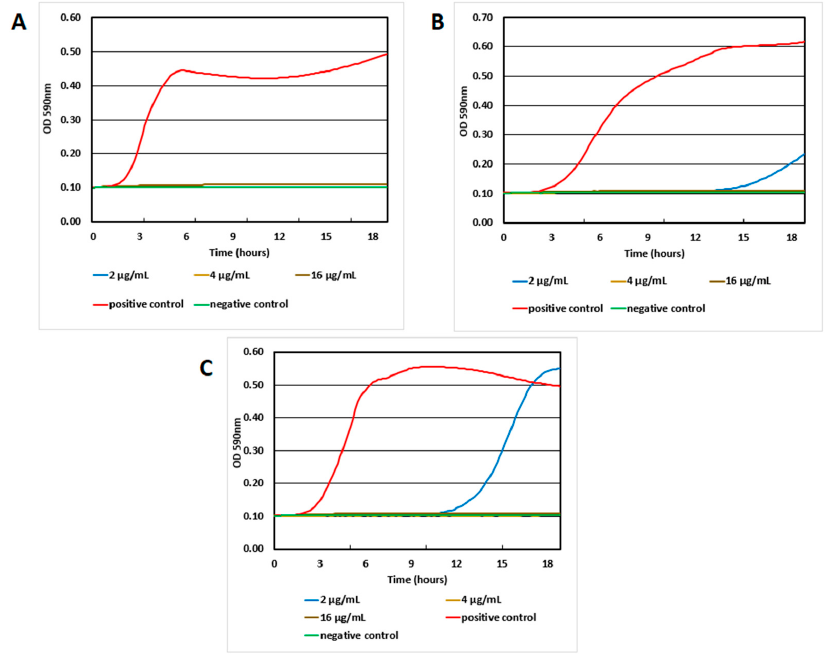
Figure 5. Bacterial growth inhibition exhibited by 7e against ( A ) S. aureus ATCC 25923, ( B ) S. aureus MRSA (CF-Marseille); ( C ) Bacillus cereus ATCC 11778 with different concentrations. Positive control was bacteria only and negative control was media only.